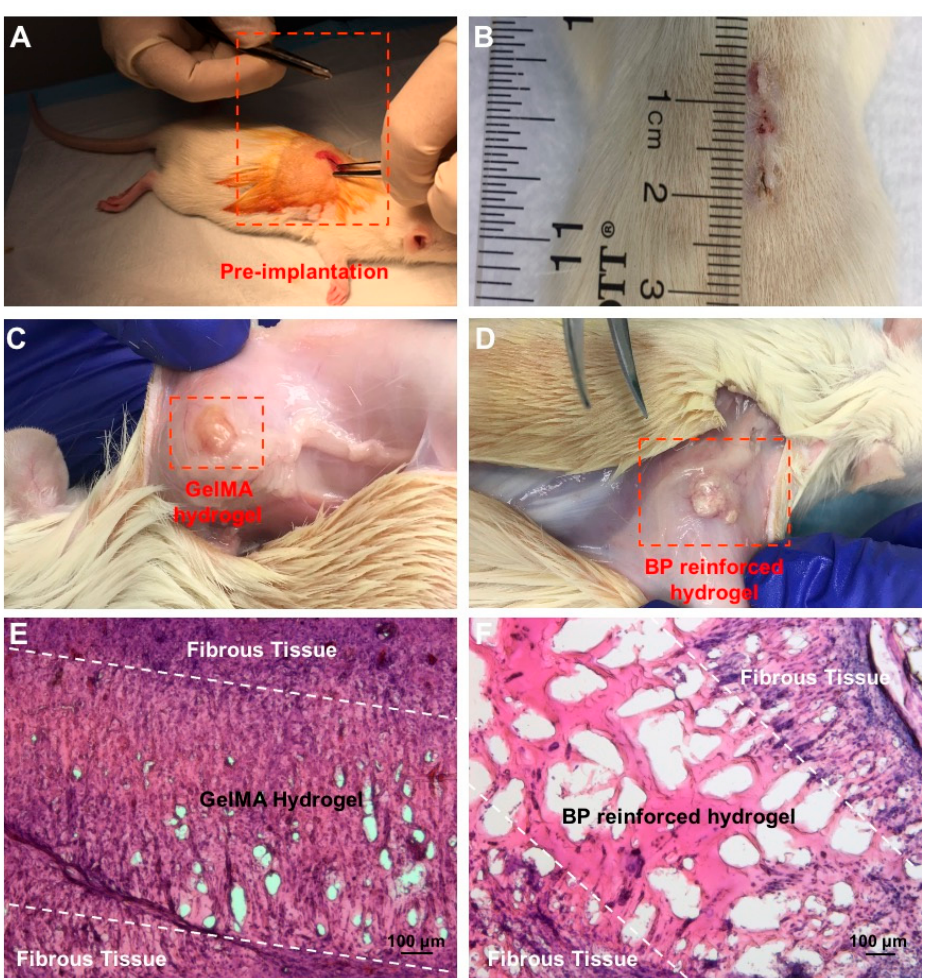
Figure 5. In vivo evaluation of subcutaneous implantation of GelMA/BP hydrogels. ( A ) Incision and subcutaneous pocket on the dorsal skin of the rat model pre-implantation. ( B ) Complete closure and healing of the incision 14 days post-implantation. ( C ) GelMA-only and ( D ) BP 50 mg/mL implants 14 days post-implantation. ( E ) H&E staining for the explanted tissue from 5% ( w/v ) GelMA-only and ( F ) BP 50 mg/mL implants 14 days post-implantation. Fibrous tissue, tissue infiltration, and minimal inflammation present within the degraded regions of both composite and control hydrogel scaffolds. Improved integration shown in BP 50 mg/mL with no presence of necrosis.